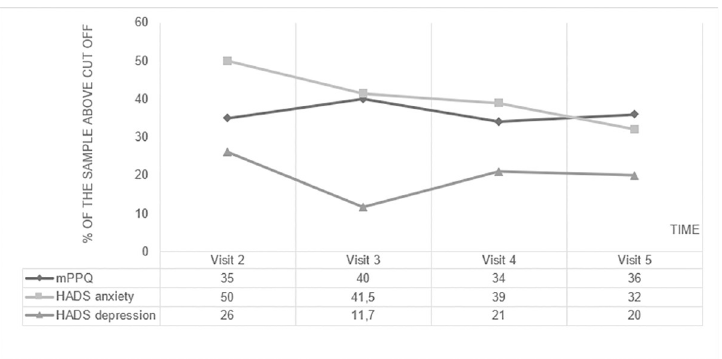
Fig 3. Point prevalences of mothers with significant posttraumatic symptoms (mPPQ score � 19), anxious symptoms (HADS anxiety � 8) and depressive symptoms (HADS depression � 8).